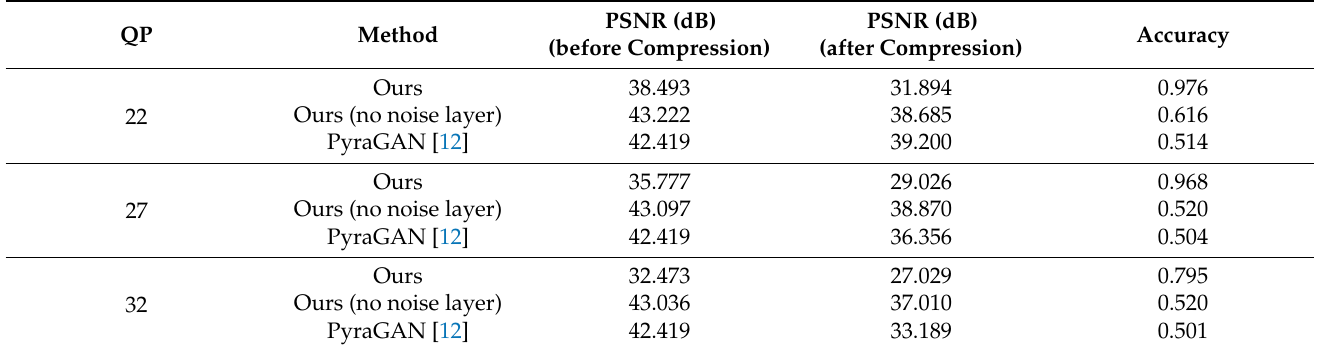
Table 2. Performance comparison of different